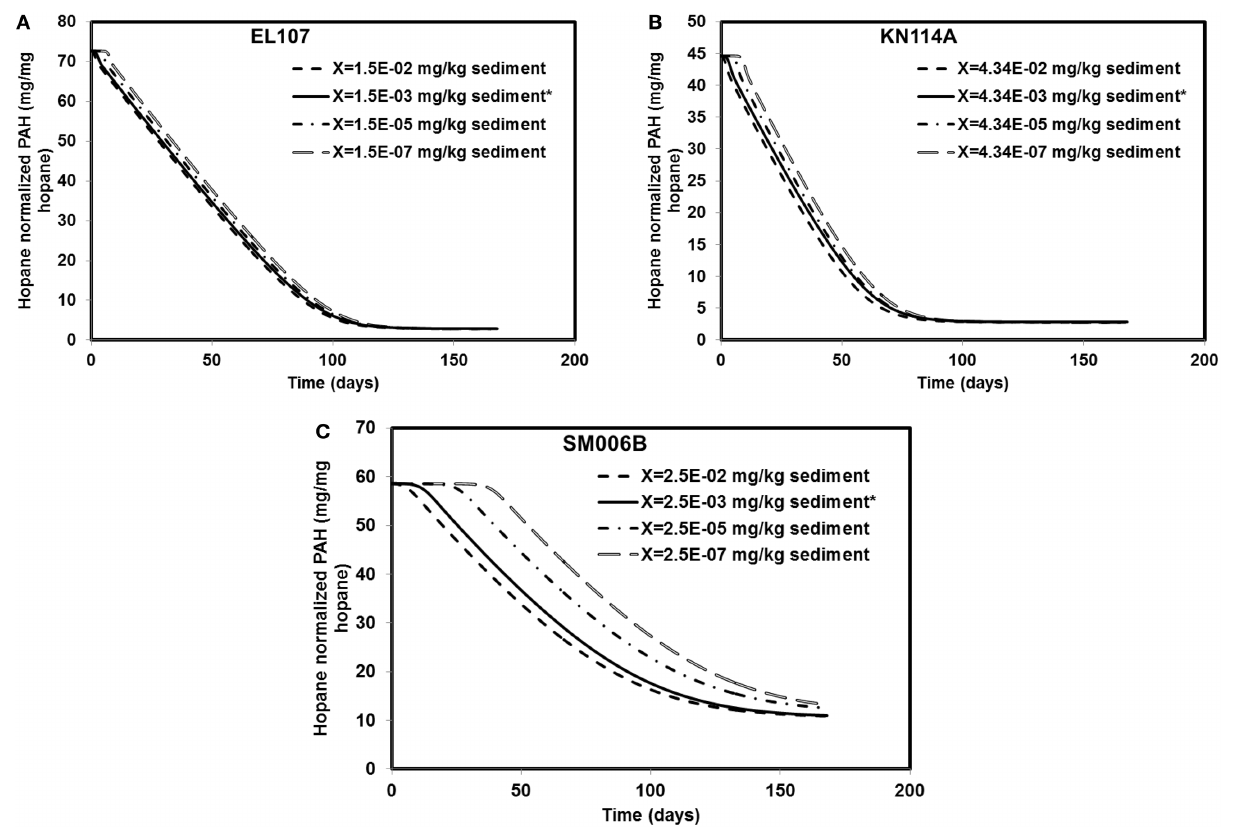
FIGURE 6 | Sensitivity of the numerical model to biomass concentration for (A) EL107, (B) KN114A, (C) SM006B. Note that X represents the initial biomass concentration. ∗ in the legend indicates the base case scenario.